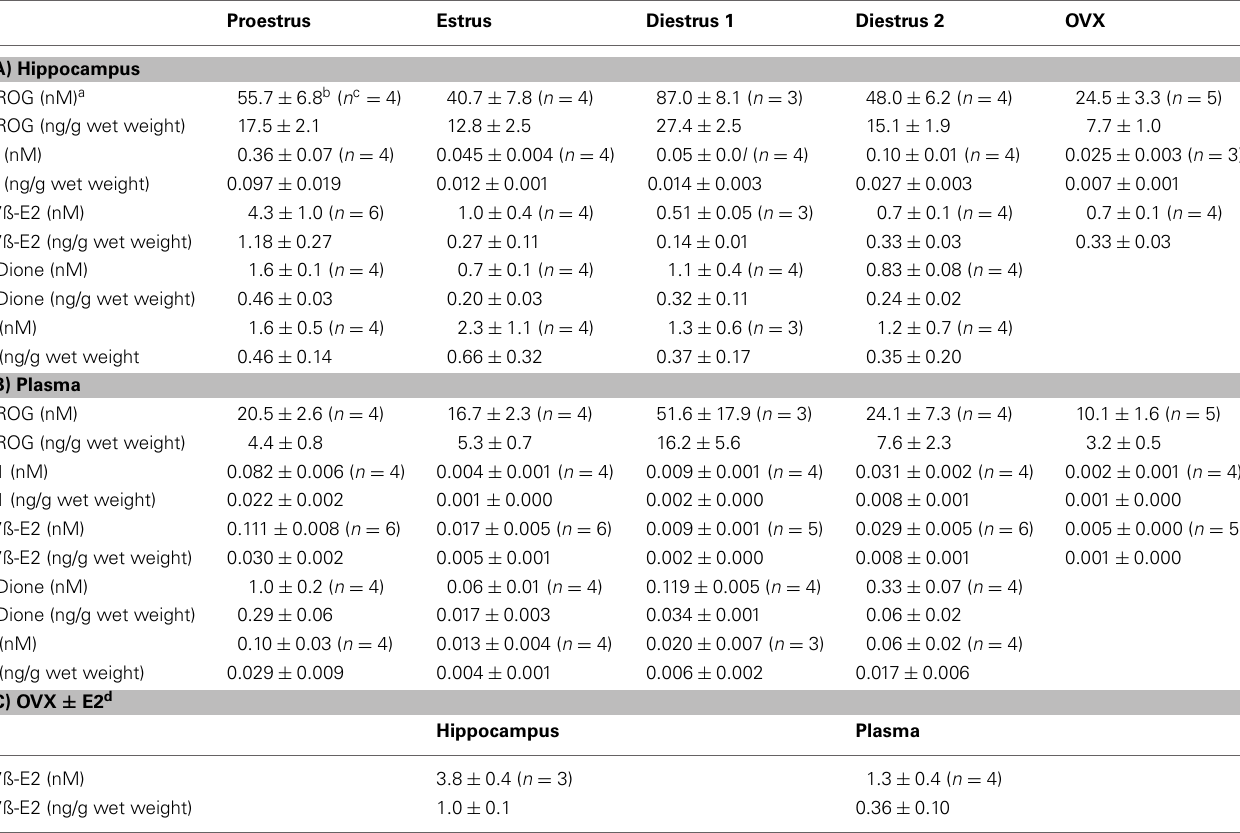
Table 1 | Mass spectrometric analysis of the concentration of steroids in the hippocampus and plasma of adult female